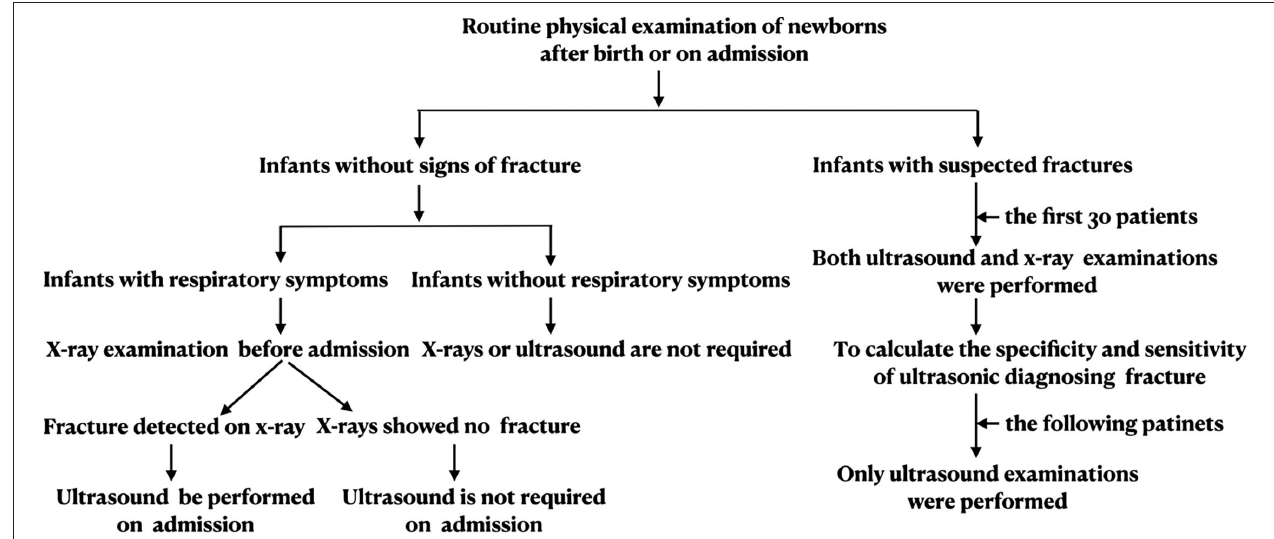
FIGURE 1 | Flow chart of the use of ultrasound to diagnose neonatal clavicle fracture. Flow chart of ultrasonographic diagnosis of clavicle fracture, refer to this process for diagnosis of other types of